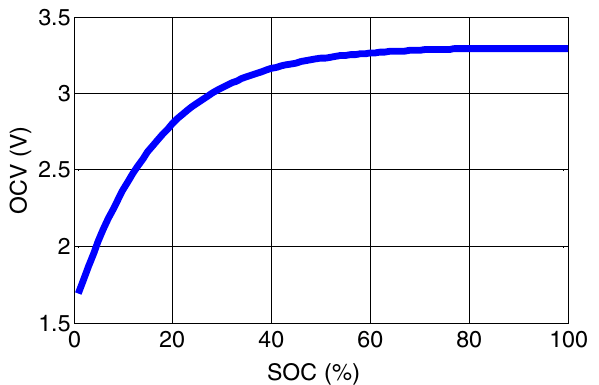
Figure 4. OCV-SOC characteristic for LiFePO 4 battery